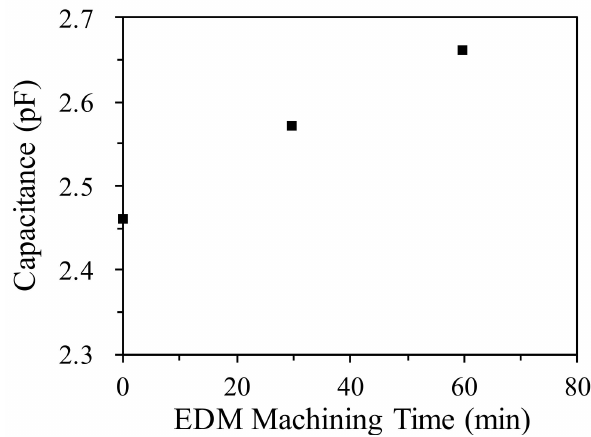
Figure 8. Measured capacitance increment for SS41 machining.